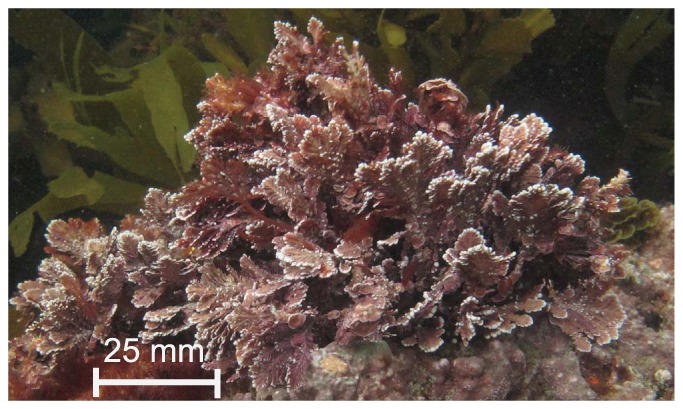
Photograph of the geniculate coralline alga Arthrocardia corymbosa taken at the collection site.